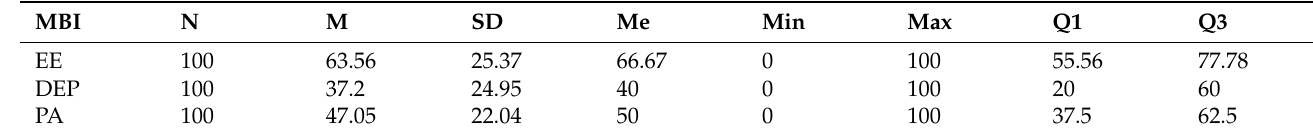
Table 6. The analysis of the MBI results.